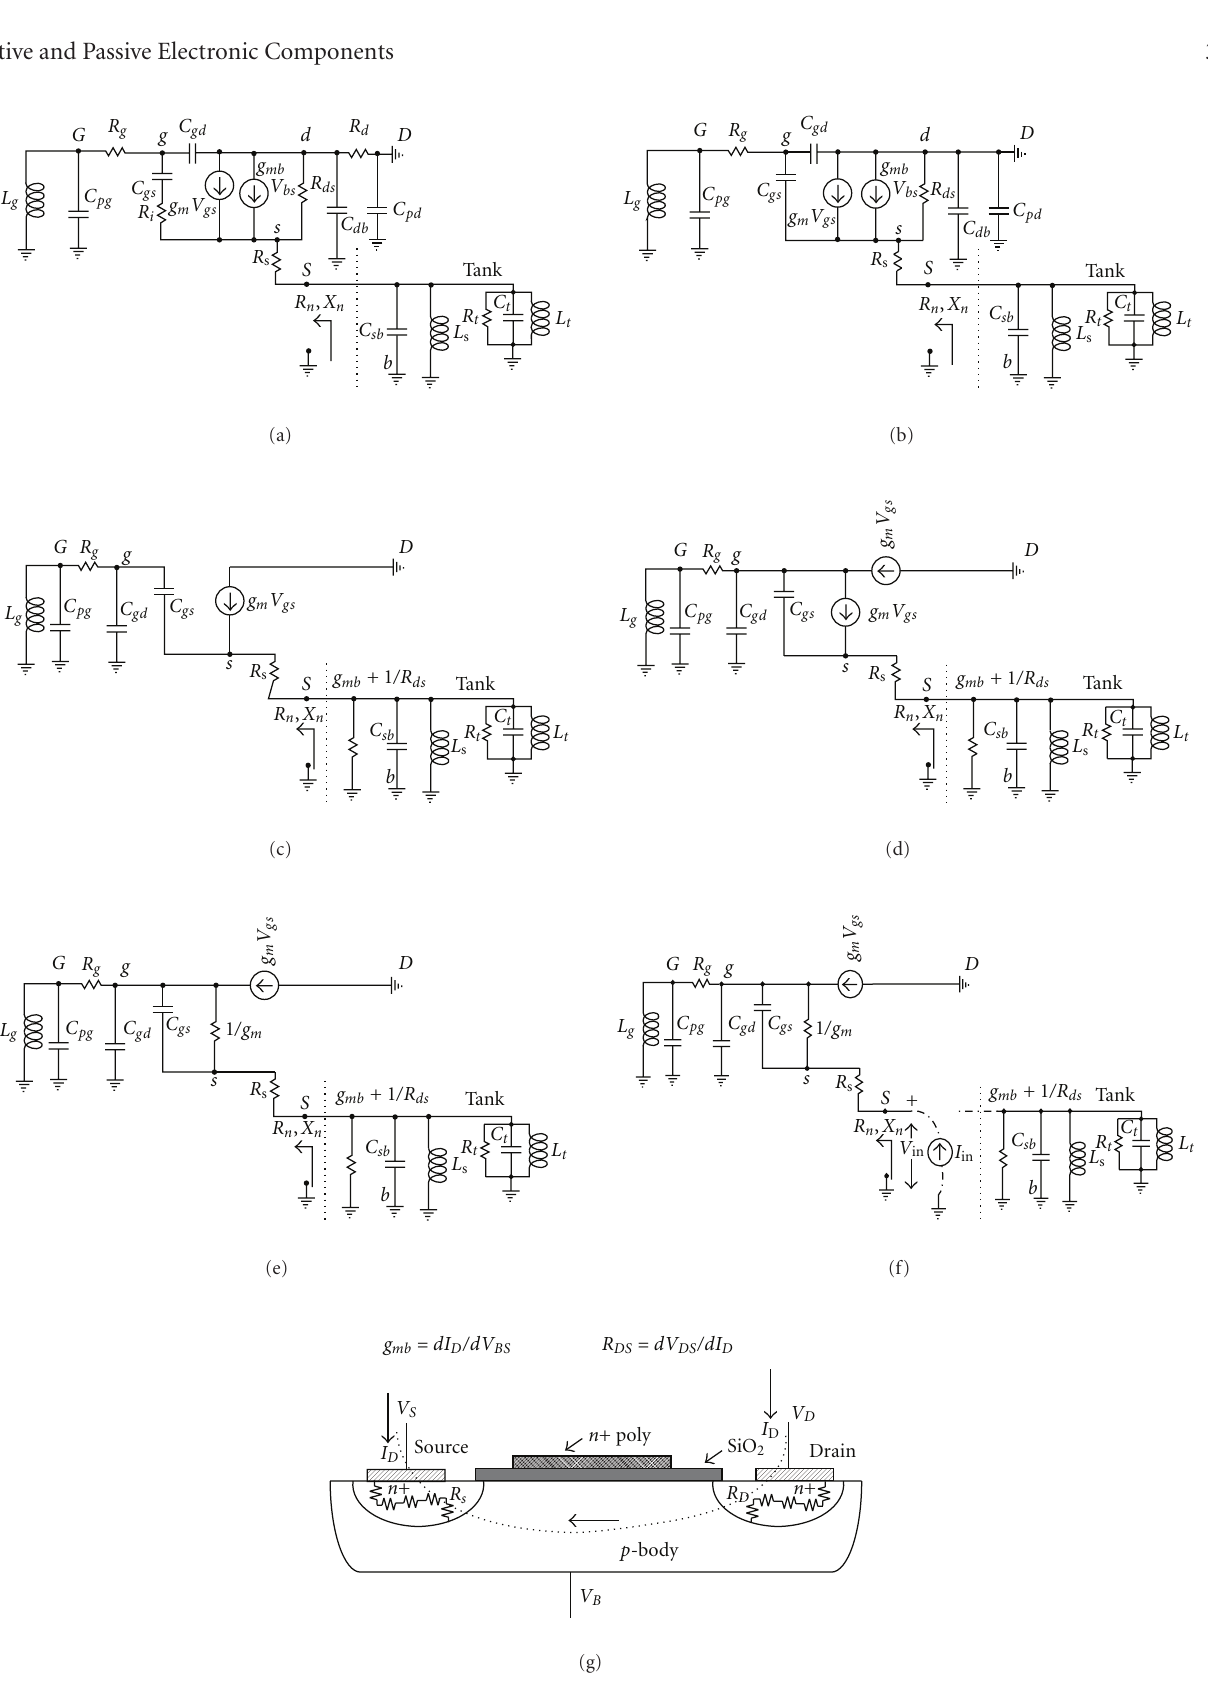
Figure 2: A small signal lumped RF model of the proposed negative resistance source follower bu ff er cell, (b)–(e) its subsequent transformations (neglecting the small resistances R d and R i ) leading to the final lumped model in (f) to find Y TH ( = 1 /R TH ) and (g) NMOS cross-section showing the interlaced location of the distributed source resistance with respect to R ds and g mb